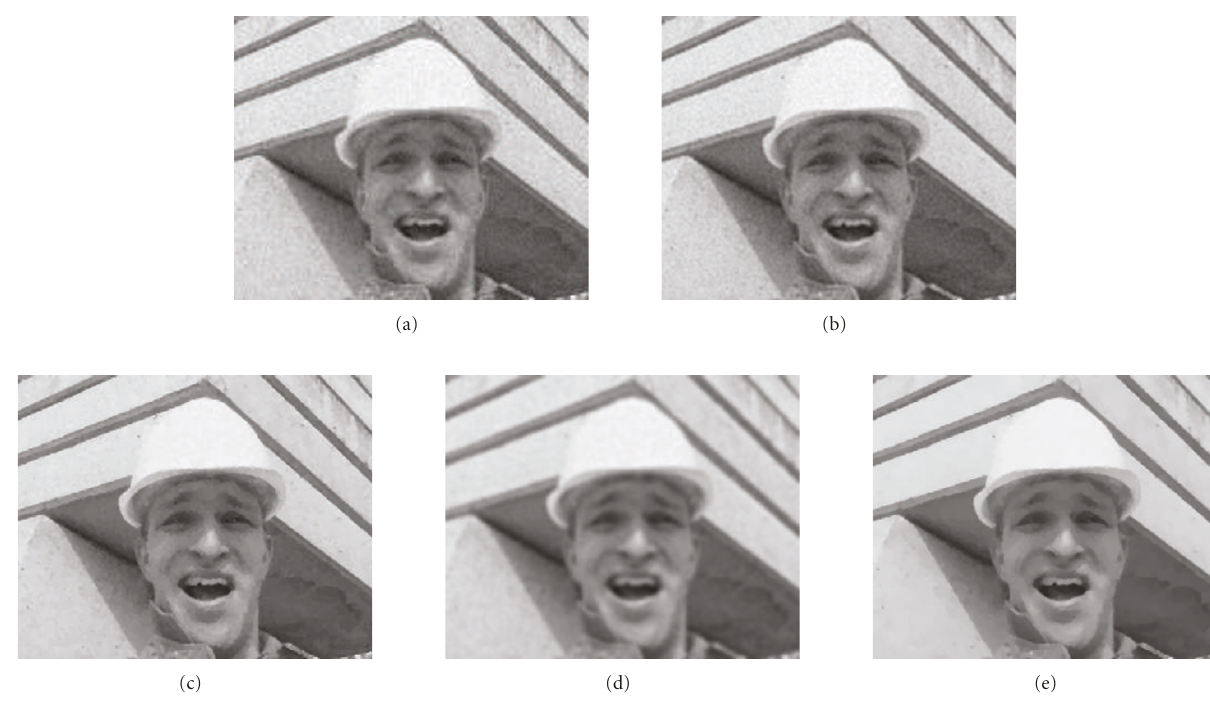
Figure 13: Experimental results in the nonsynthetic “noise” case. (a) LR frame, (b) Laplacian SR result with λ = 0 . 128, (c) TV SR result with λ = 2 . 048, (d) Laplacian SR result with λ = 2 . 048, and (e) TV SR result with λ = 4 . 096.